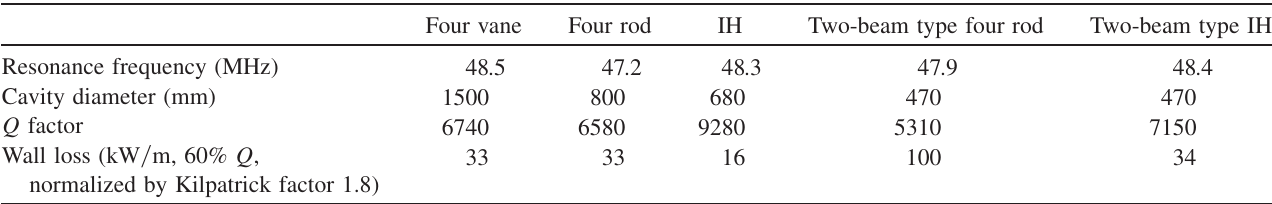
TABLE IX. The rf properties of the RFQ linacs at approximately the resonance frequency of 48 MHz.